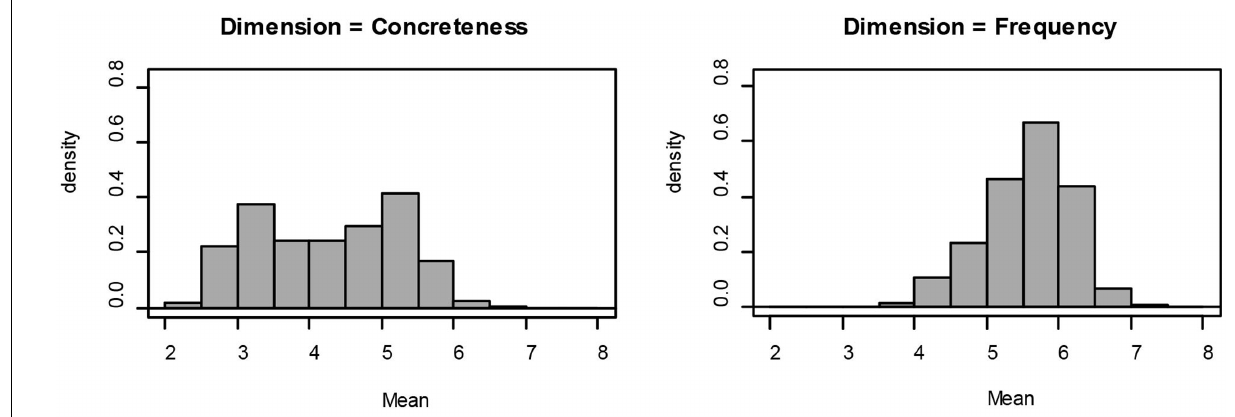
FIGURE 2 | Distribution of Concreteness and Frequency ratings.